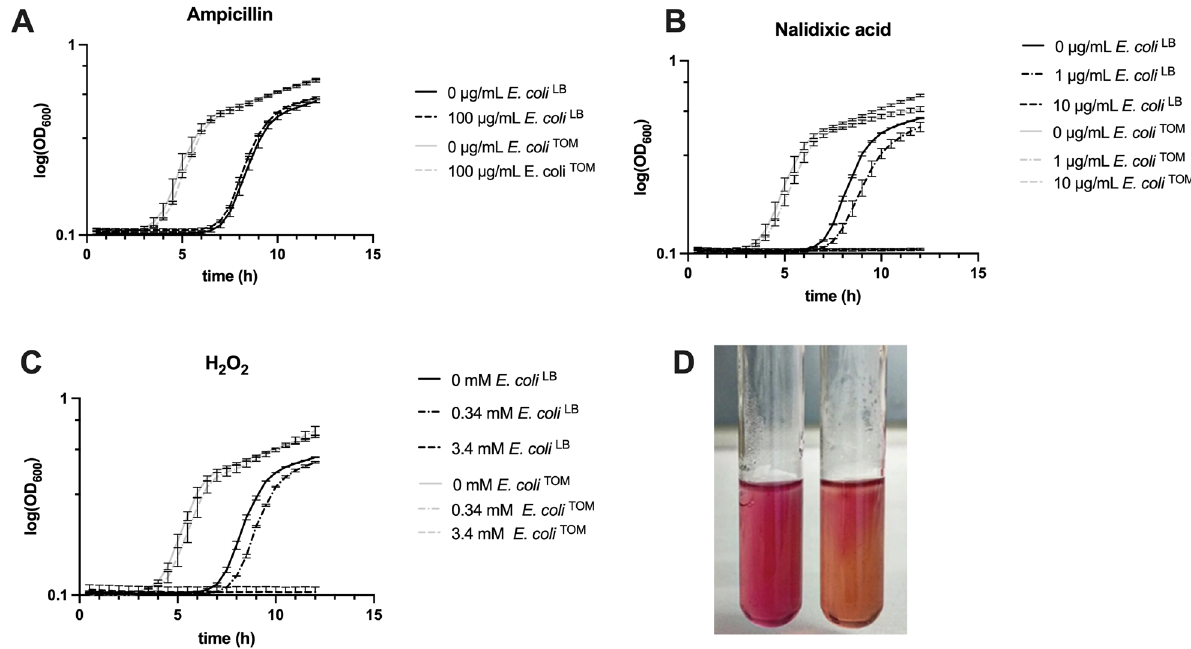
Figure 3. Di ff erent growth of E. coli TOM and E. coli LB in di ff erent conditions. Growth curves of E. coli TOM and E. coli LB in the presence/absence of ( A ) ampicillin (control), ( B ) nalidixic acid, and ( C ) H 2 O 2 ; ( D ) di ff erent acidi fi cation by E. coli TOM (left tube) and E. coli LB (right tube) into semi-solid MacConkey, possibly indicating di ff erent motility. Error bars represent standard error.